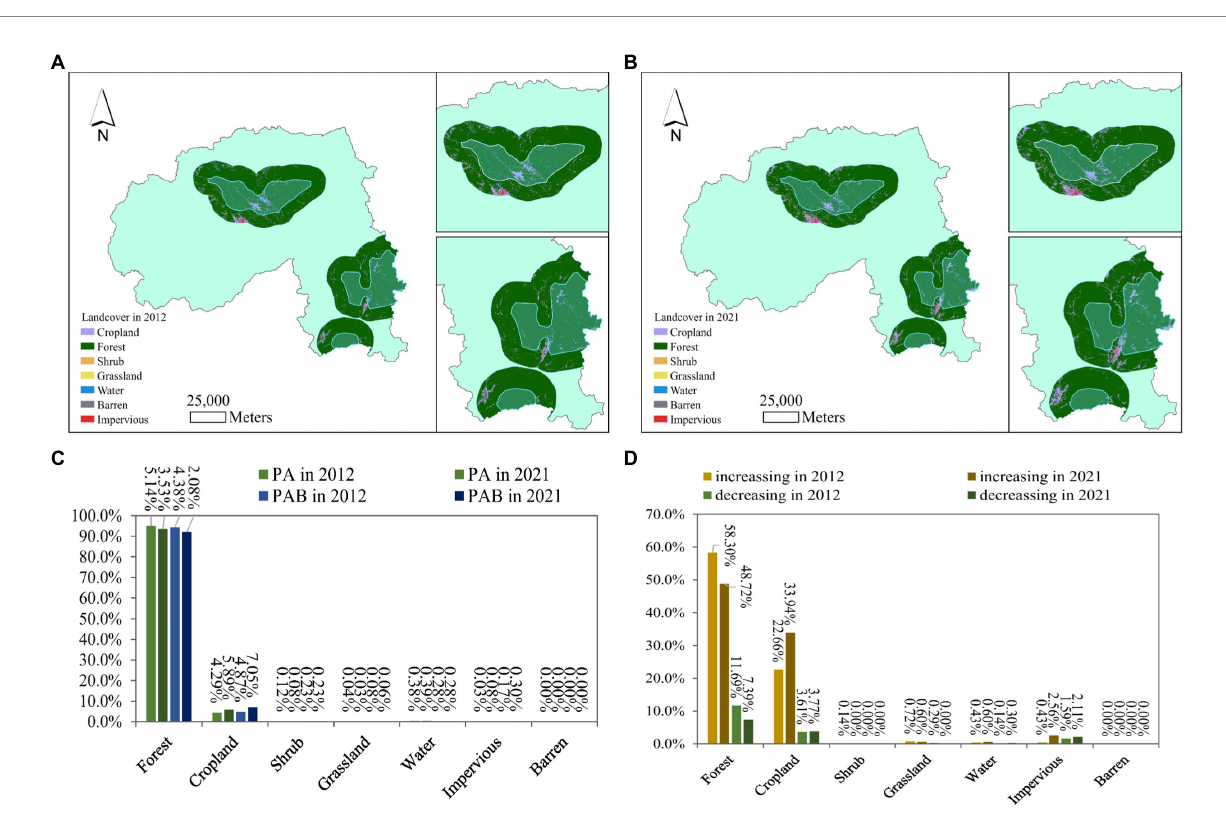
Figure 4A where NTL showed different trends, we counted the NTL trends of different LC under the same location and plotted Figure 5D. The areas where NTL has a significant trend of change, forest and cropland more dominant, and the areas where forest shows different trend are decreasing and farmland is increasing. The increasing trend of impervious from 2012 to 2021 is not obvious, but the increasing trend presented by NTL is significant, from 0.43 to 2.56%.